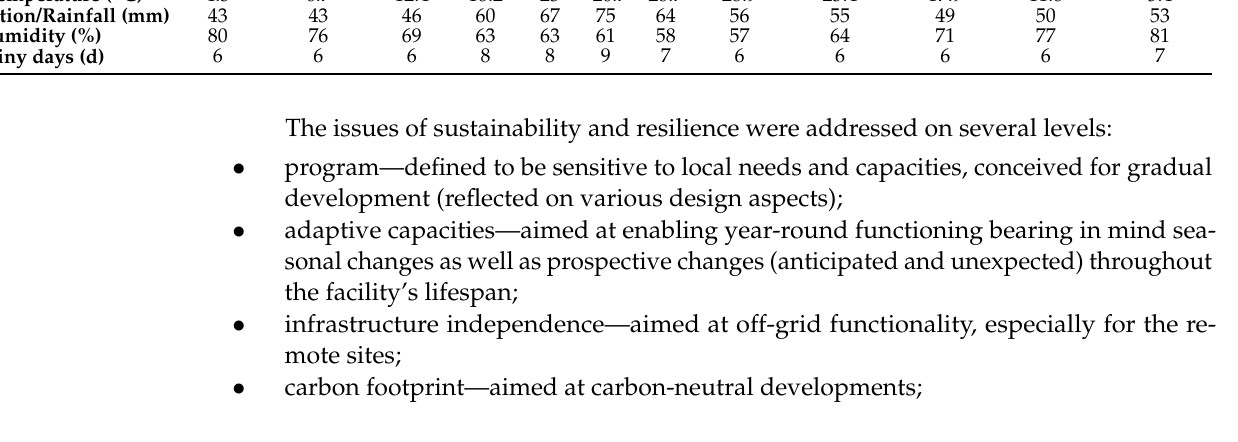
Table 1. Weather data for Vojvodina [31].